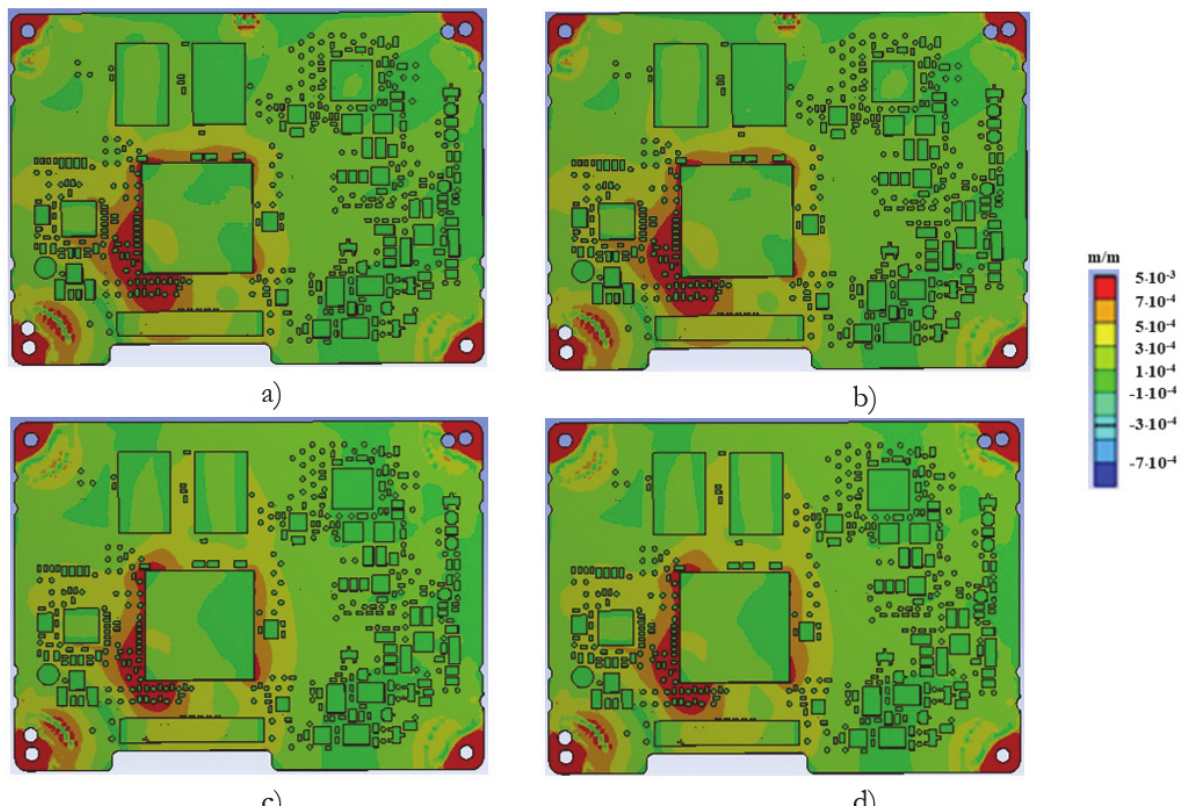
Figure 6: FEA results for maximum principal strains: a) Loading case 1 - FR4 experimental determined; b) Loading case 1 - FR4 Ansys database; c) Loading case 2- FR4 experimental determined; d) Loading case 2 - FR4 Ansys